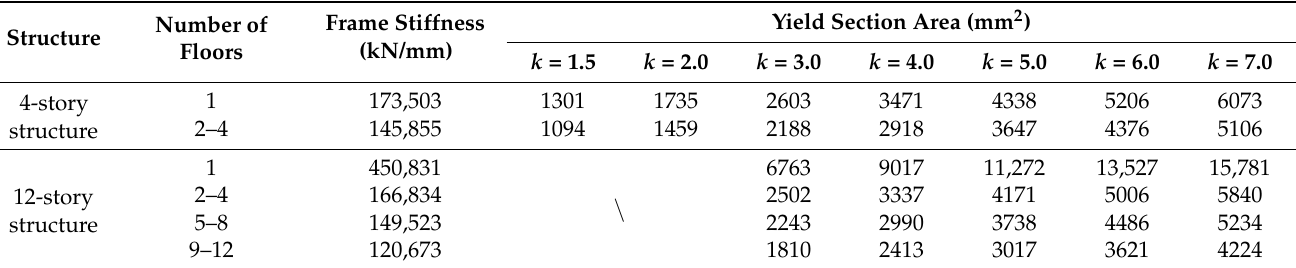
Table 8. Yield section area of BRBs with each stiffness ratio.